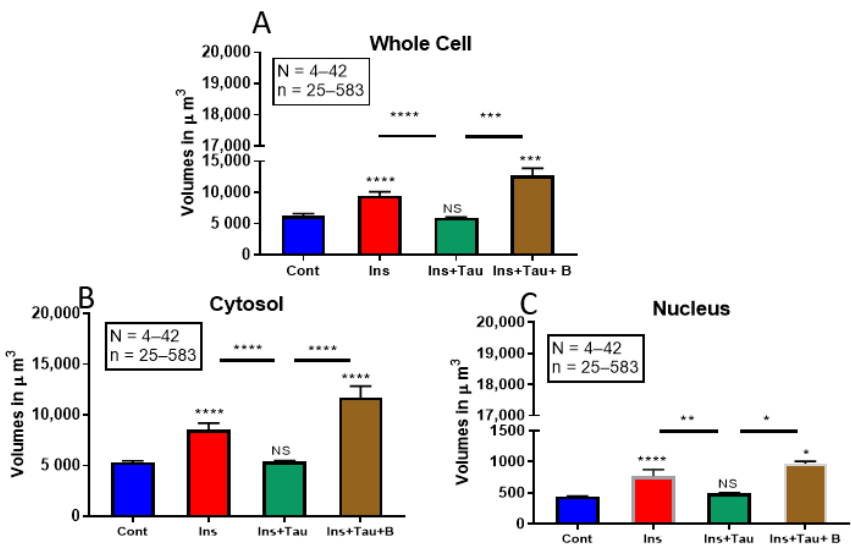
Figure 2. Histograms showing the effect of a 48-h treatment with insulin (80 µ U/mL), insulin (80 µ U/mL) with taurine (20 mM), and insulin (80 µ U/mL) with taurine (20 mM) and β -alanine (500 µ M) on the volume of adult rat ventricular cardiomyocytes. The results show the volume of the whole cell ( A ), the cytosol ( B ), and the nucleus ( C ) in the absence of treatment and in the presence of a 48-h treatment of insulin (80 μ U/mL), insulin (80 μ U/mL) + taurine (20 mM), and insulin (80 μ U/mL) + taurine (20 mM) + β -alanine (500 μ M). The values are represented as mean ± standard error of the mean. N represents the number of animals, and n represents the number of cells. **** p < 0.0001, *** p < 0.001, ** p < 0.01, and * p < 0.05 were considered significant. NS = non-signifiant. N was 42 (control), 42 (insulin), 7 (insulin + taurine), and 4 (insulin + taurine + β -alanine) for the different experiments. n was 226 (control), 158 (insulin), 33 (insulin + taurine), and 57 (insulin + taurine + β -alanine) for the different cells. Cont = control; ins = insulin; tau = taurine; and B= β -alanine. The volume of the cell is in μ m 3 .